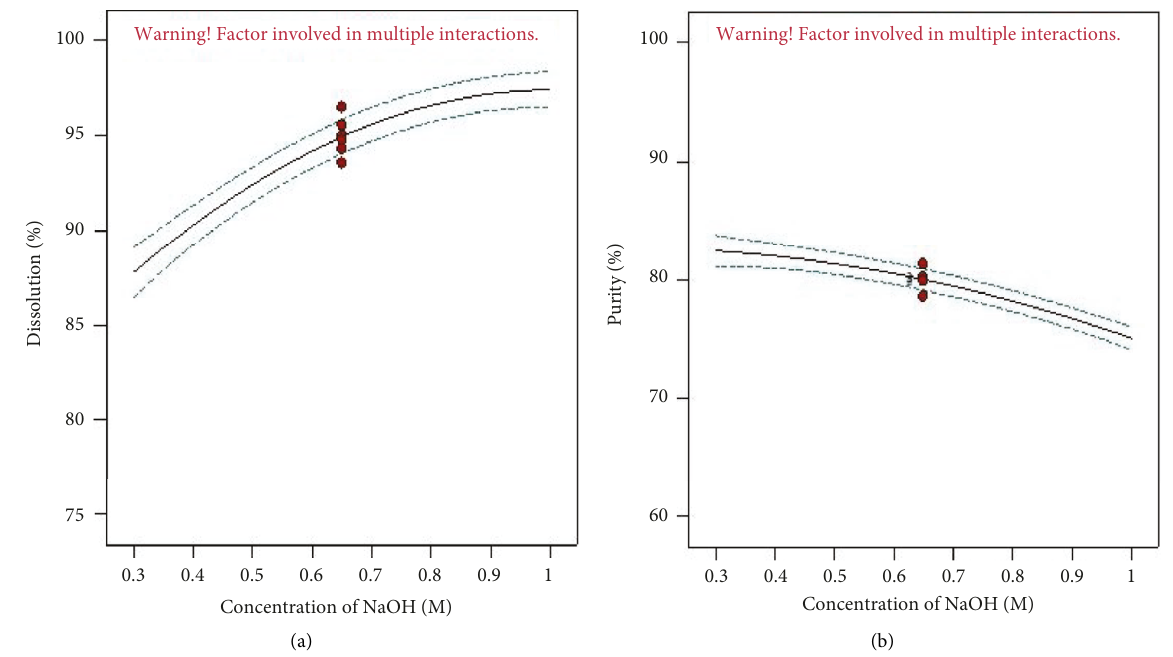
Figure 6: Effect of NaOH concentration on (a) dissolution percentage and (b) purity of keratin.